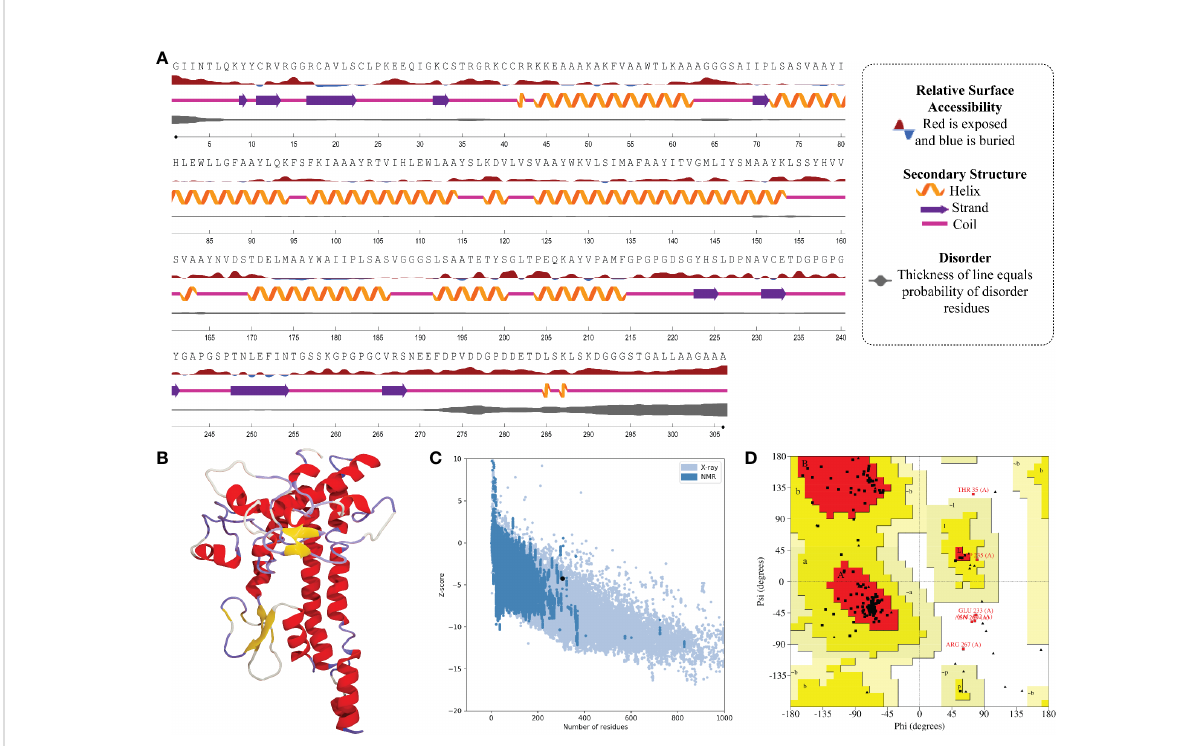
FIGURE 3 Structural analysis and validation of MPXV-1 (A) The predicted secondary structure features, relative surface accessibility, and disorder regions using NetsrurfP-3.0 server (B) Final 3D modeled structure of the constructed vaccine (C) Z-score graph via ProSA-web showing the modeled 3D structure corresponds to X-Ray crystallographic determined structure for the protein of similar sizes (D) Ramachandran plot details of the fi nal modeled structure of designed